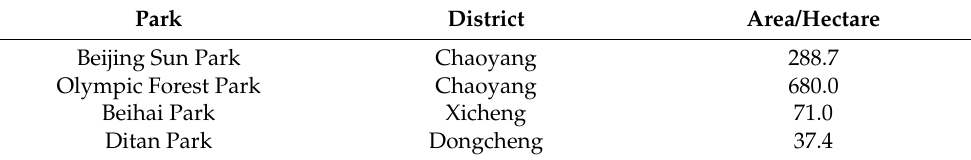
Table 1. Urban parks in